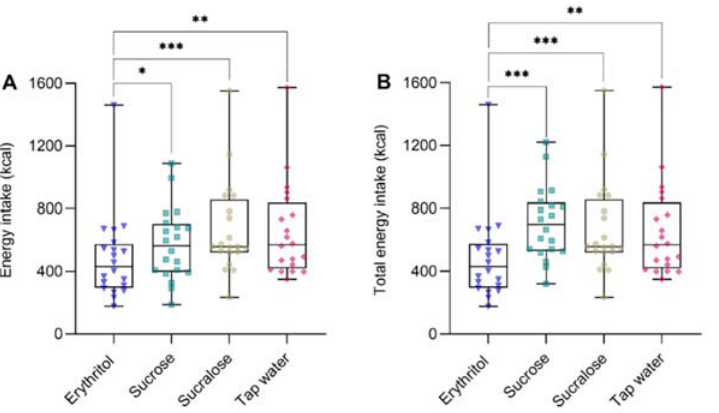
Figure 2. ( A ) Energy intake (kcal) from the ad libitum test meal and ( B ) total energy intake (kcal) (preload + ad libitum test meal) after oral administration of preloads containing either 50 g erythritol, 33.5 g sucrose, 0.0558 g sucralose, or tap water. Data are shown as median and interquartile range with individual values for each substance (triangle = erythritol, square = sucrose, circle = sucralose, and rhombus = tap water), and absolute values are presented. Statistics: linear mixed models followed by planned contrasts using post-hoc Student’s t -tests with Tukey correction for multiple testing in case of overall significance. *** p Tukey < 0.001; ** p Tukey < 0.01; * p Tukey < 0.05. n =